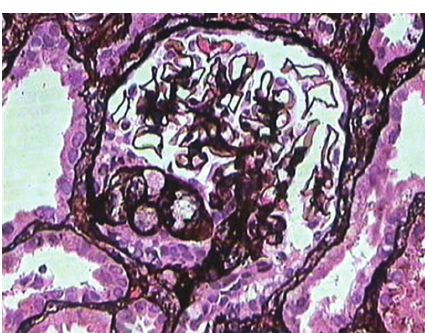
Figure 1: Medium-power view showing a glomerulus with segmen- tal scarring associated with intracapillary foam cells and adhesion formation with Bowman’s capsule, in a case of classic focal segmen- tal glomerulosclerosis. (Silver stain, × 200).